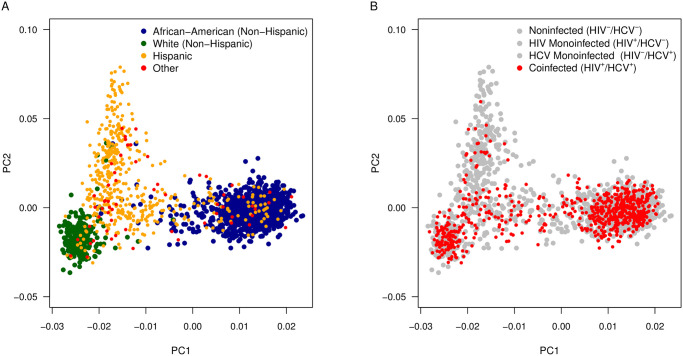
Genomic estimates of race/ethnicity using principle component analysis.The 1,858 WIHS participants utilized in this study were stratified using 185 ancestral SNV markers from across the genome. PC1 and PC2 are depicted above. Genomic estimates of race and ethnicity were compared to reported race and ethnicity (A) and the distribution of HIV/HCV coinfected participants of focus are displayed (B).